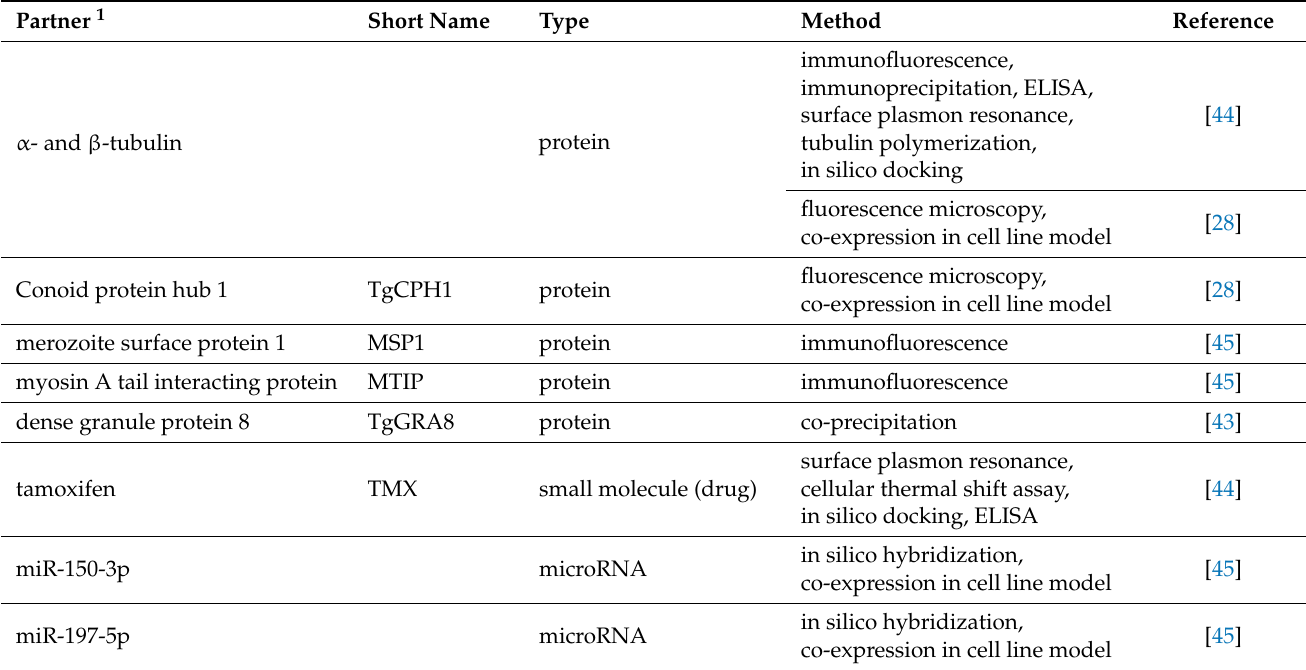
Table 1. Interactions of apicortin at protein and RNA